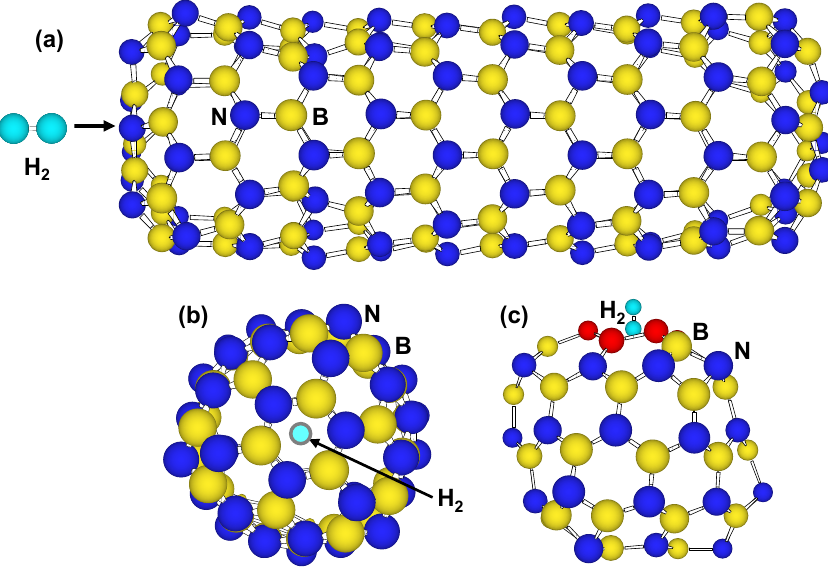
Figure 4. Structure models that H 2 molecule passes through hexagonal BN rings of ( a , b ) tip of B 99 N 99 nanotube and ( c ) B 36 N 36